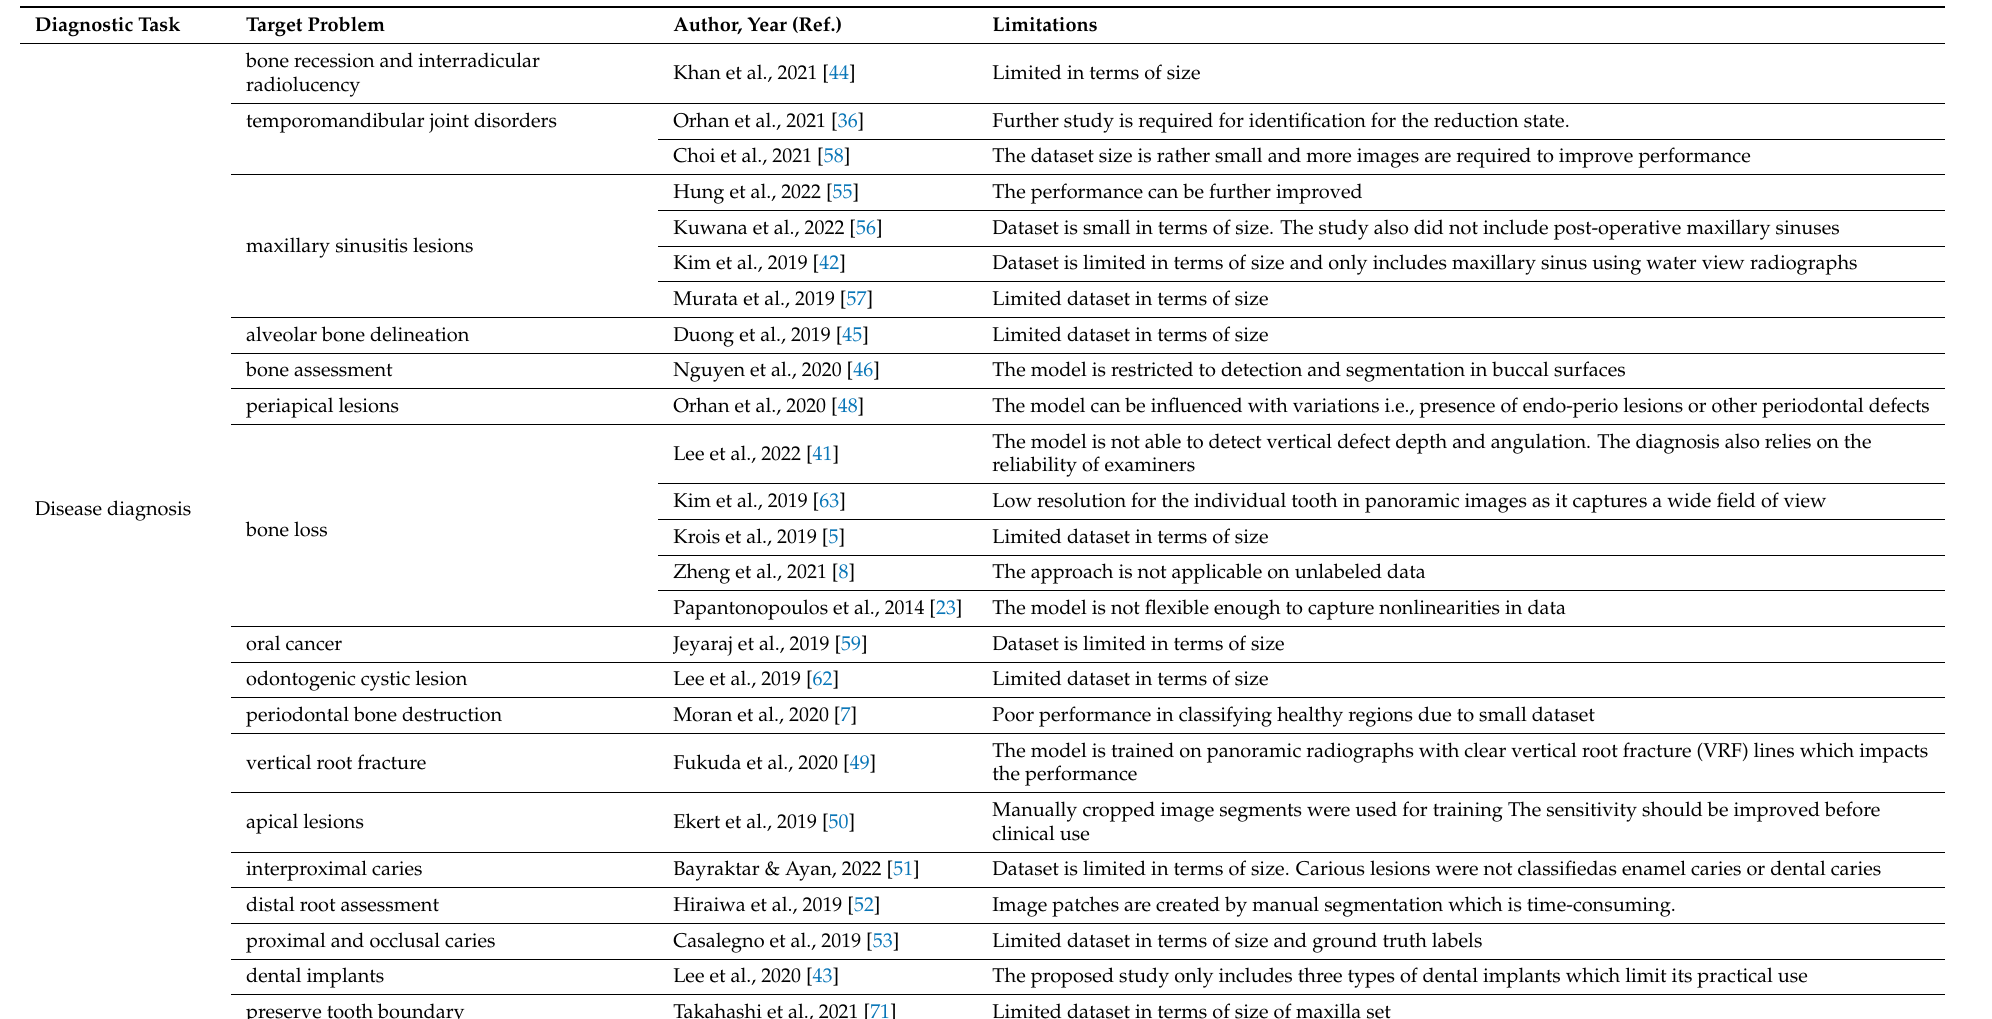
Table 8. Limitations of relevant studies employing AI for disease